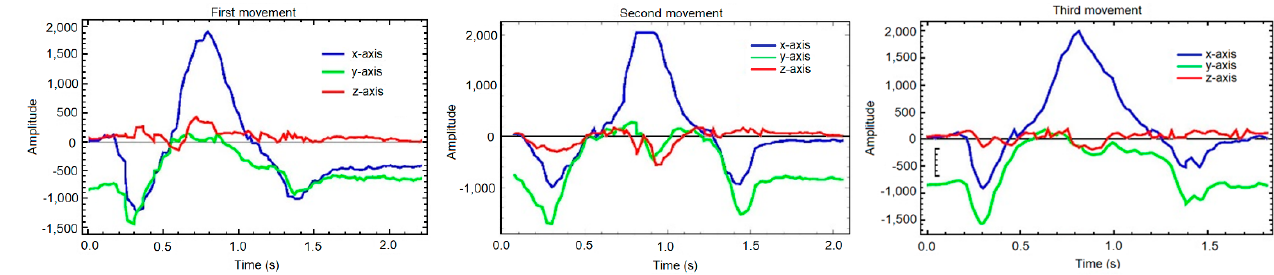
Figure 8. Three samples of the same circular wrist turn movement, and their variation over time in the three axes.